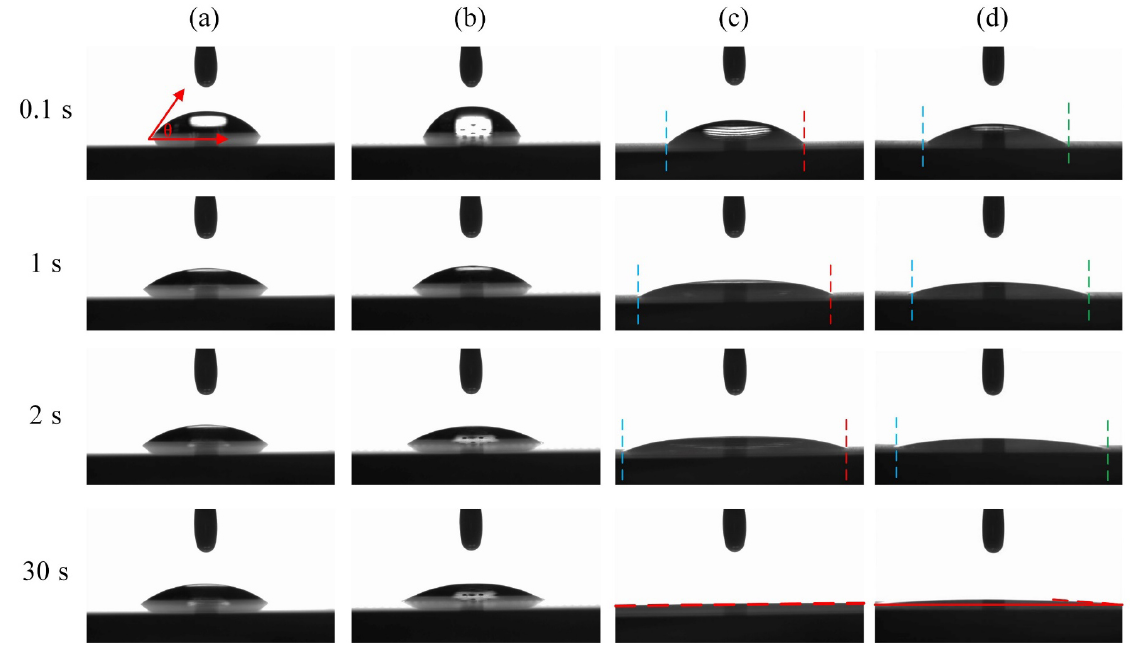
Fig. 8 Wettability of four surfaces for PAO40. (a) NB, (b) DB, (c) GB, and (d) GGB.